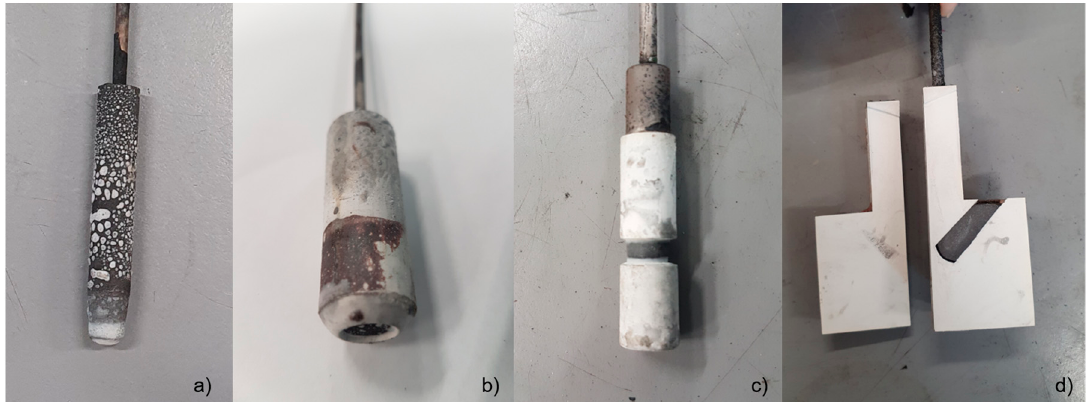
Figure 12. Pictures of the anodes after the experiment: ( a ) rod anode, ( b ) horizontal anode, ( c ) vertical anode and ( d ) inverted horizontal anode (cross-sectioned).